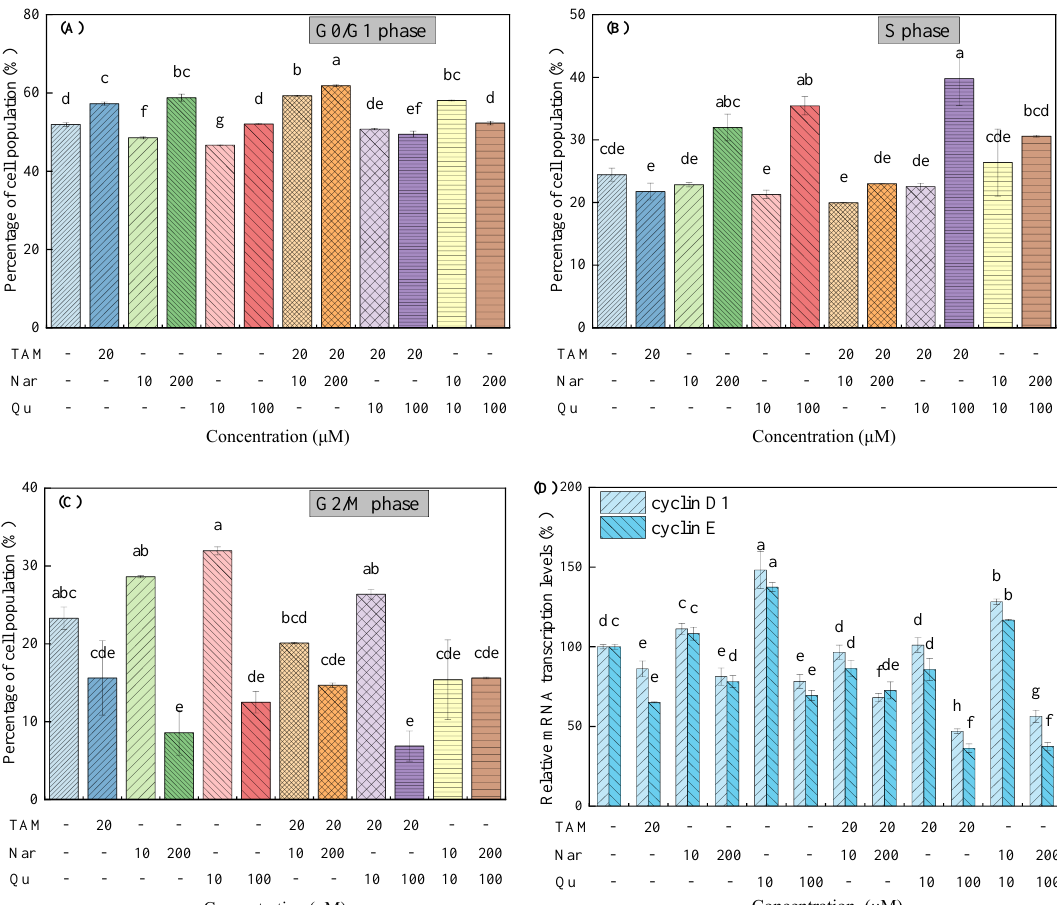
Figure 4. Tamoxifen, naringenin and quercetin regulated cell cycle progression in HepG2 cells. Cells were exposed to tamoxifen (20 μM), naringenin (10 and 200 μM) and quercetin (10 and 100 μM) either alone or in combination for 24 h. Percentage of cell population in the ( A ) G0/G1 phase, ( B ) S phase and ( C ) G2/M phase, respectively. ( D ) Tamoxifen, naringenin and quercetin regulated the mRNA transcription of cell cycle-related genes. Results are expressed as mean ± SD of three independent experiments ( n = 3). a,b,c,d,e,f,g,h : Different letters indicate significant differences ( p < 0.05) in cell cycle distribution and their regulated genes.